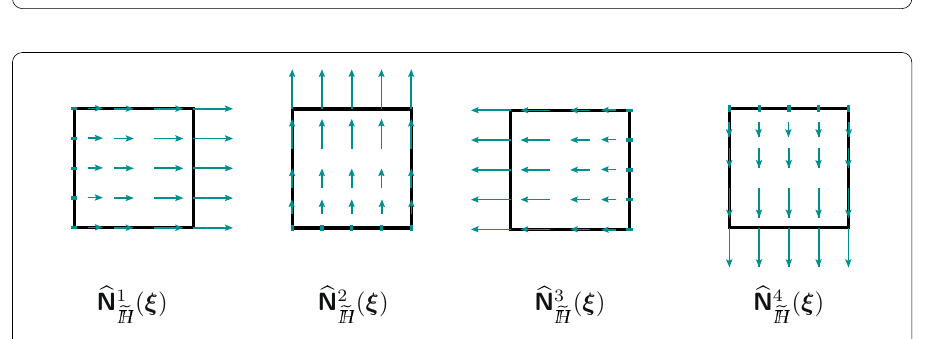
Fig. 4 Illustration of the RT 0 shapefunctionsinparametricspace . The normal projections of the RT 0 shape functions are constant along the edge of a finite element in the parametric space A . The projection of the shape function associated with edge K onto the edge E K is given by (cid:14) N K (cid:5) = 0. The factor 1 / 2 is due to the length of the element edge in edges (cid:14) E L with L (cid:10)= K is (cid:14) N K (cid:5) ( ξ ) · (cid:14) N e 0 H